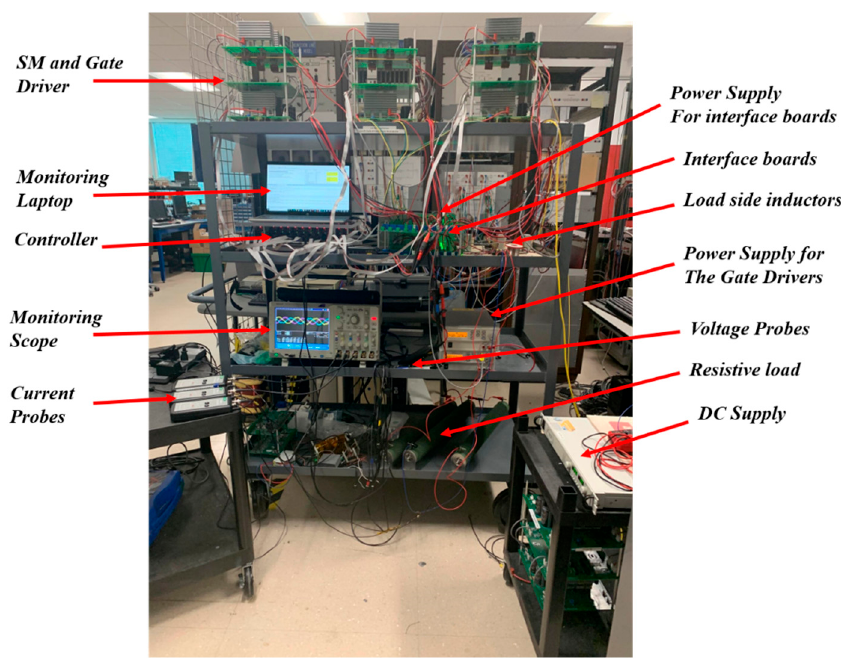
Figure 11. A photo of the test-setup with MMC prototype and the